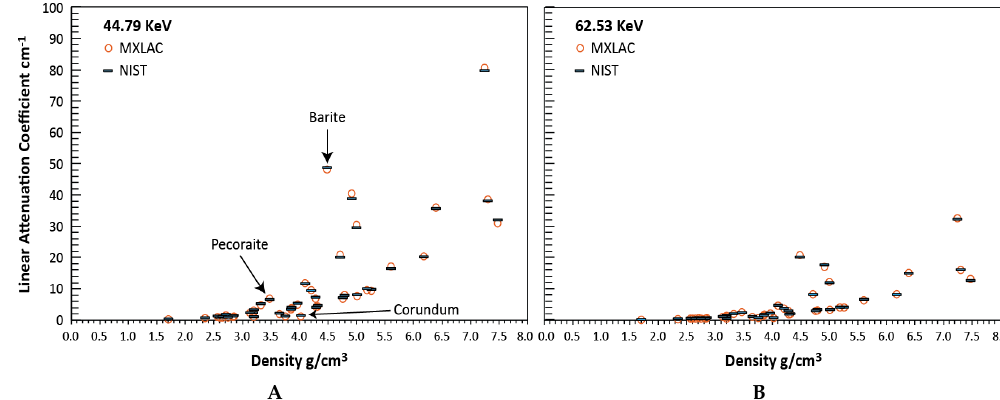
Figure 5. Variation of linear attenuation coefficients for different mineral densities calculated with MXLAC and NIST at: A) 44.79 keV and B) 62.53 keV X-ray energy.